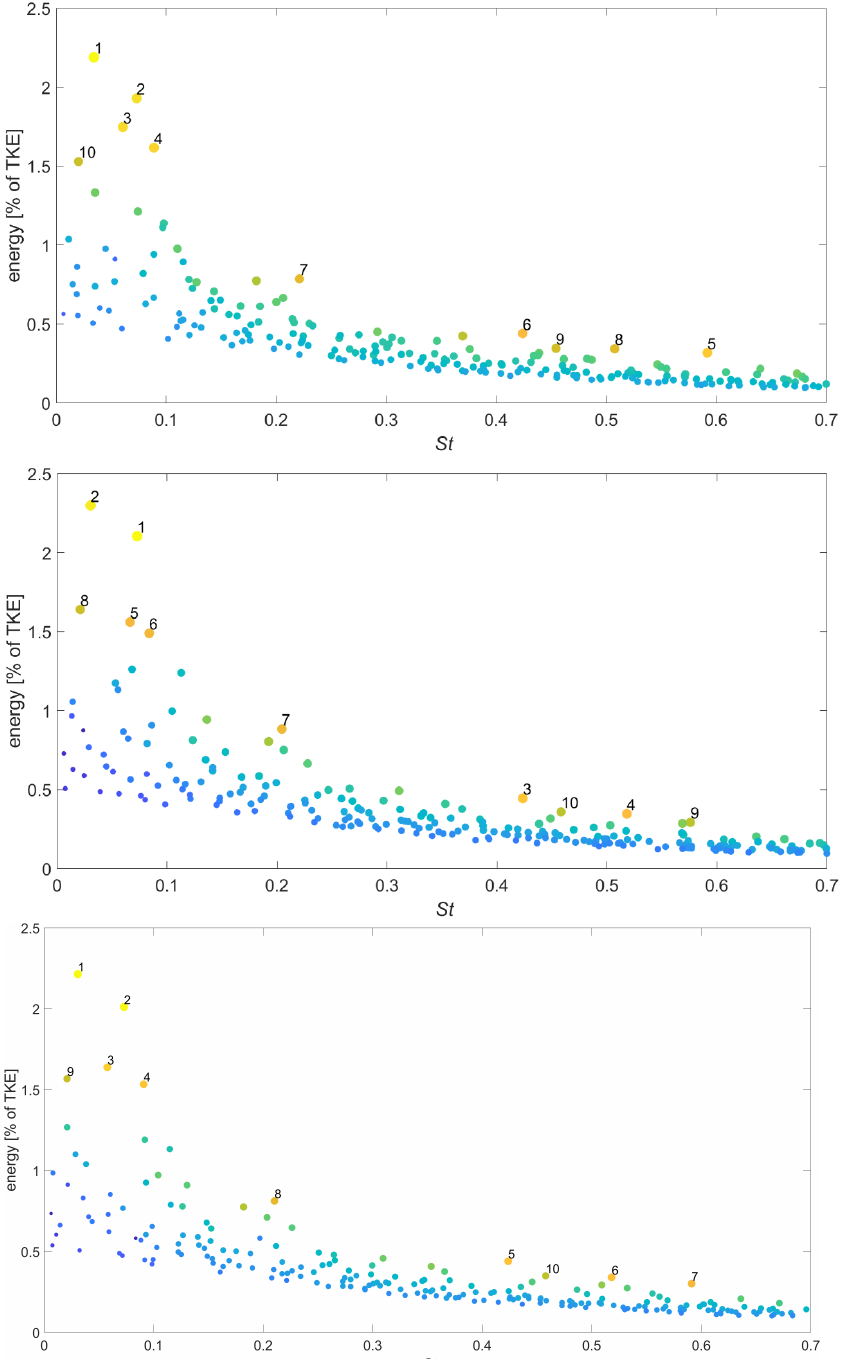
Figure 3. SPOD spectrum of Y-cut data ( top ), Z-cut data ( middle ) and YZ-cut data ( bottom ), with the 10 highest harmonics